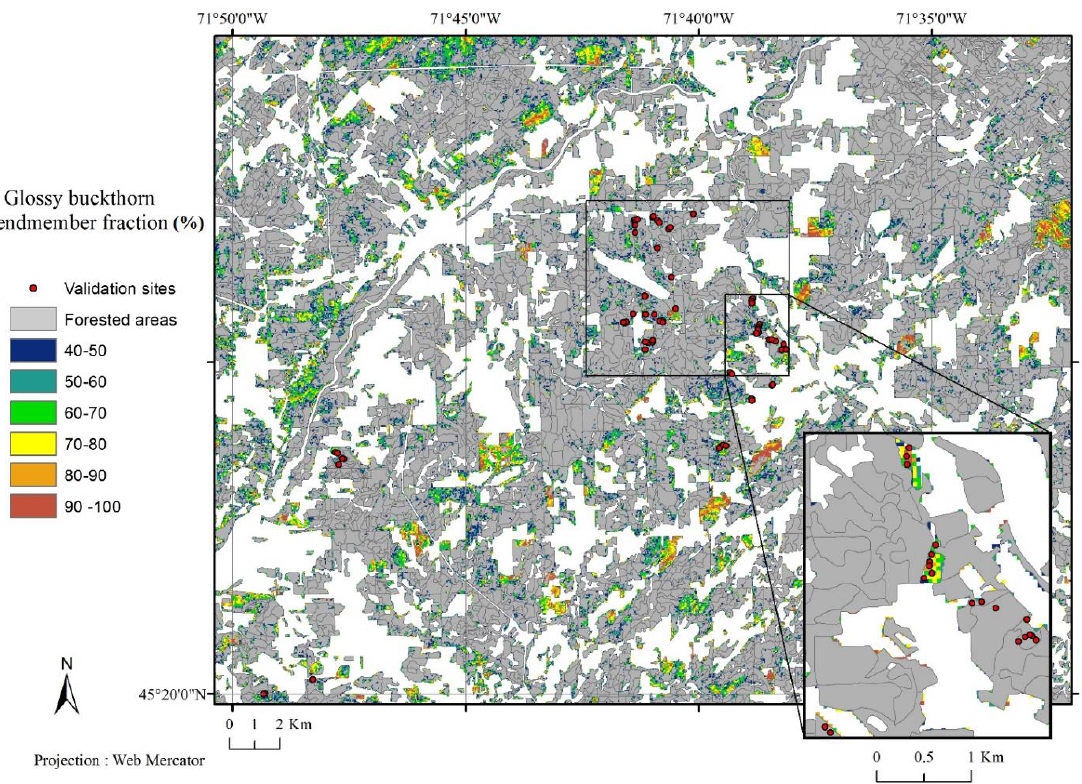
Figure 4. Glossy buckthorn endmember fraction (%) in mixed and deciduous forest stands of the Cookshire zone estimated from linear unmixing of a Landsat 8 NDVI time series (2013–2015).